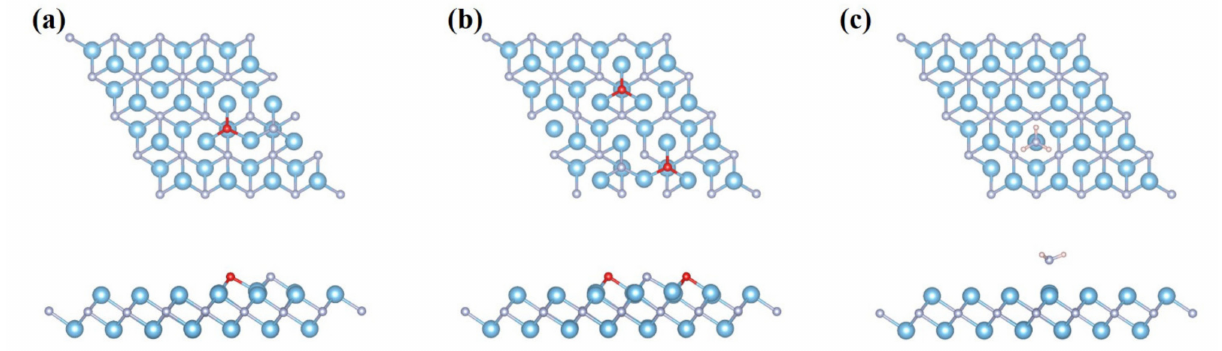
Figure 2. Top and side view of the optimized atomic structures for Ti 2 N monolayer after adsorbing ( a ) NO, ( b ) NO 2 , and ( c ) NH 3 (blue, silver, red, and pink balls represent Ti, N, O, and H atoms,